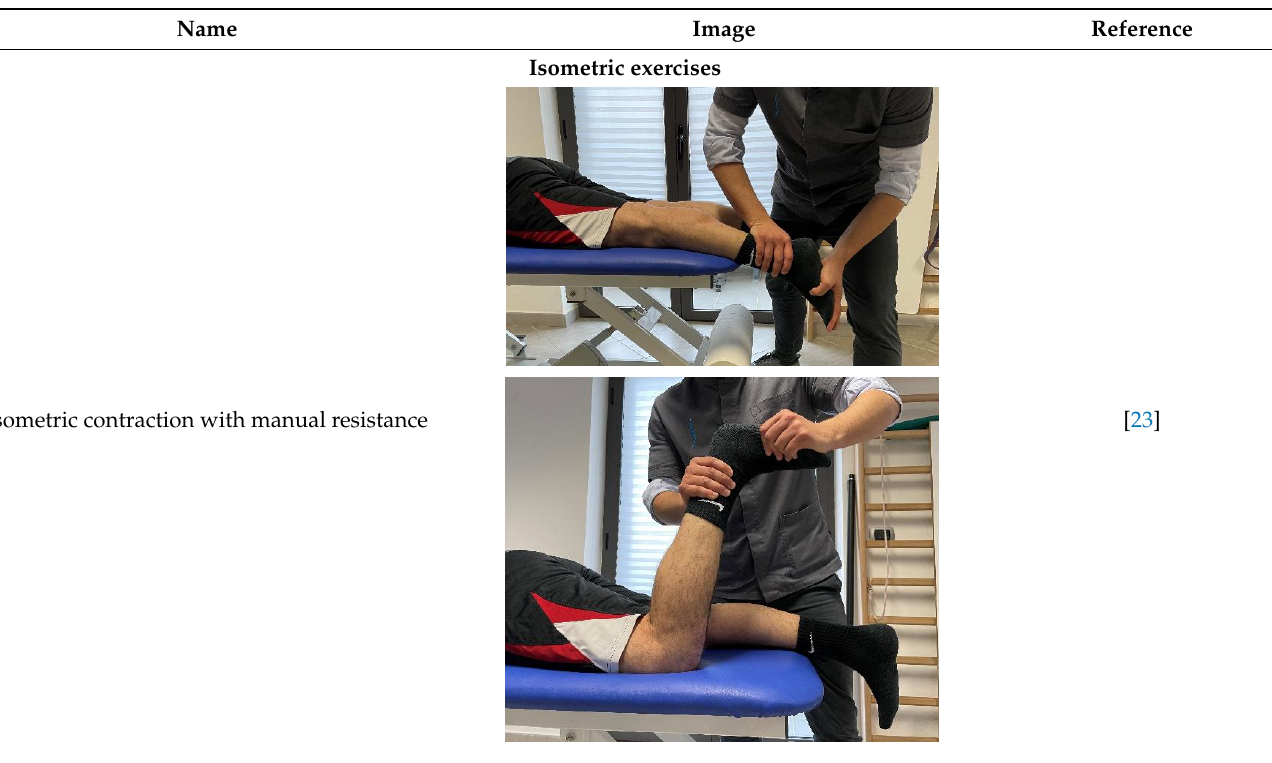
Table 5. Soleus-gastrocnemius rehabilitation exercises.